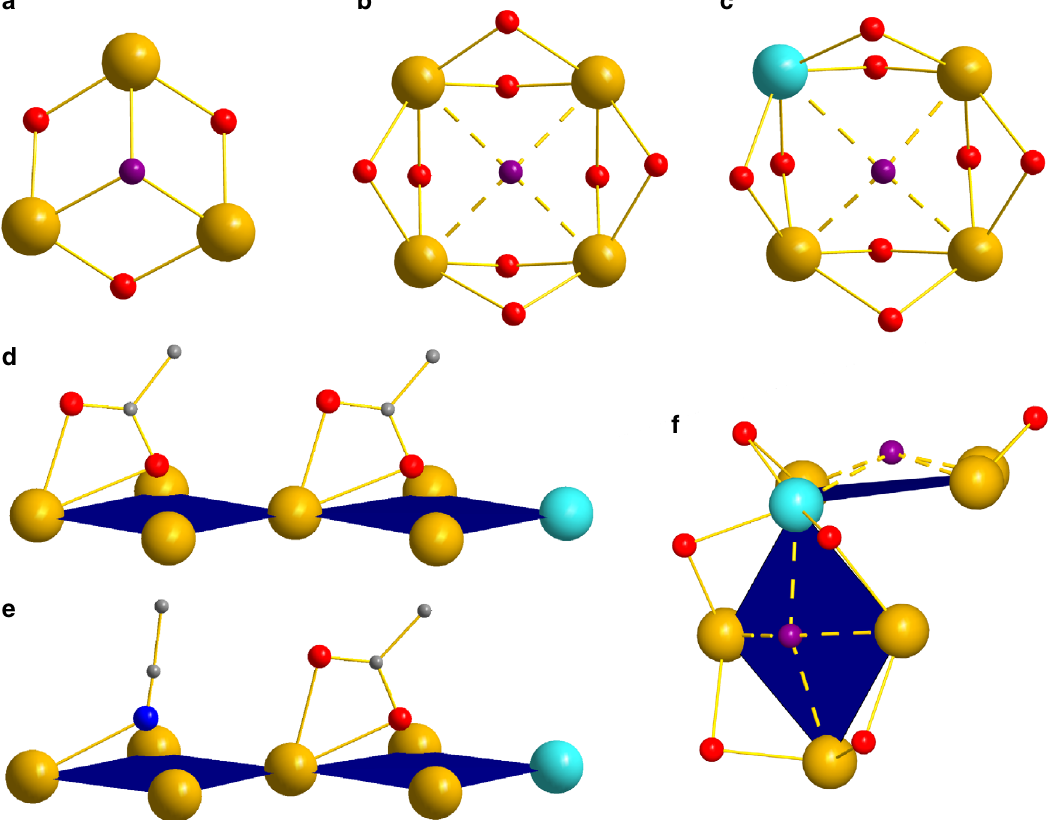
Fig. 3 Structural features on the surface of ceria nanoclusters. a μ 3 -OH − on (111) Ce IV 3 triangle; b μ 4 -OH − on a (100) Ce IV 4 square; c μ 4 -OH − on a (100) Ce III Ce IV 3 square; d η 2 -carboxylates in 3a acting as lids on adjacent (100) Ce IV 4 and Ce III Ce IV 3 squares; e the analogous situation in 3b to that in d , with an MeCN ligand replacing one η 2 -carboxylate as lid; and f μ 4 -OH − lids on a V-shaped (100) Ce III Ce IV 3 double-square in 1 linked at the Ce III corner. Color code: Ce IV gold, Ce III sky-blue, O red, OH − purple, N blue, C grey. H atoms have been omitted for